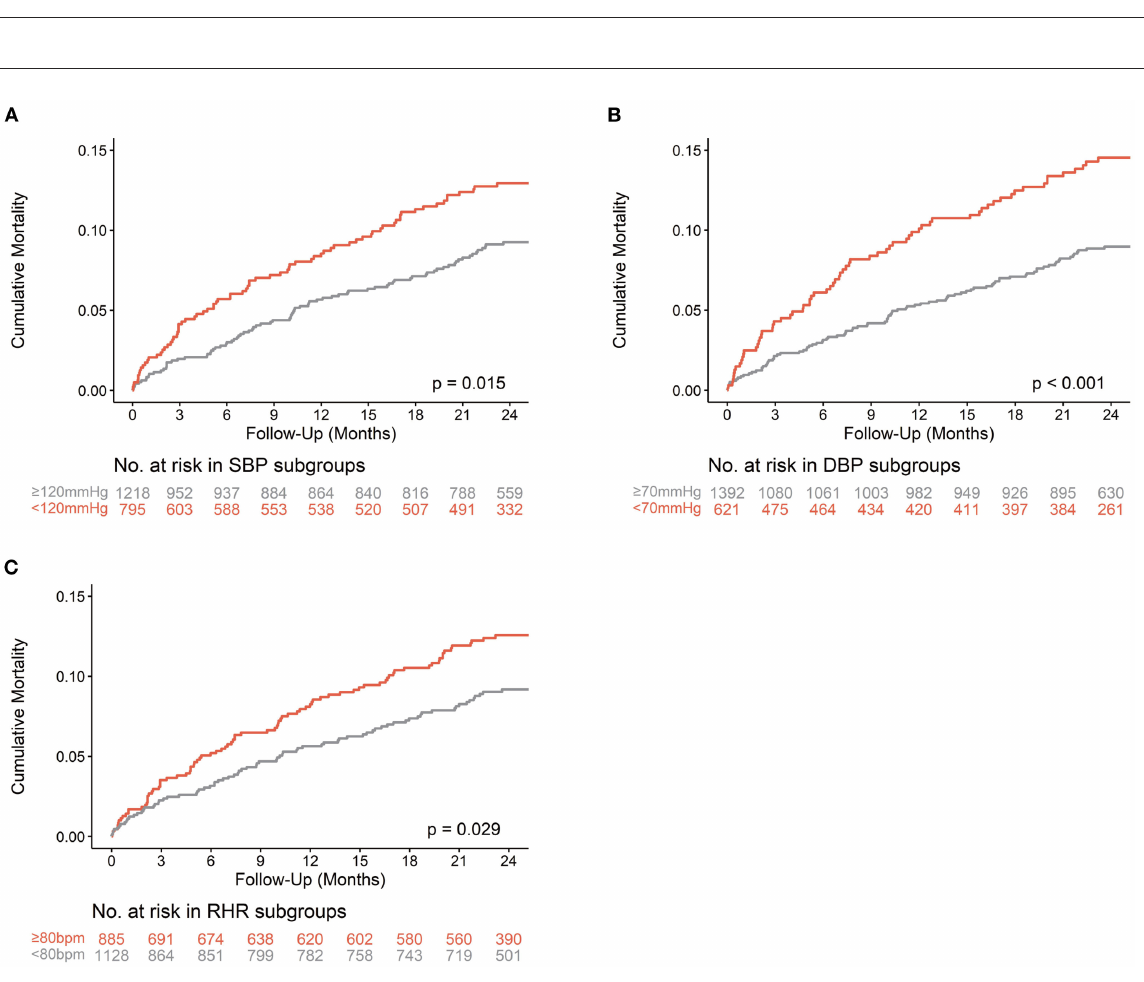
FIGURE2 Kaplan-Meier curves of all-cause Mortality. The Kaplan - Meier curves of all-cause mortality are shown according to thresholds of SBP (A) , DBP (B), and RHR (C) in patients with TR. Bpm, beats per minute; DBP, diastolic blood pressure; RHR, resting heart rate; SBP, systolic blood